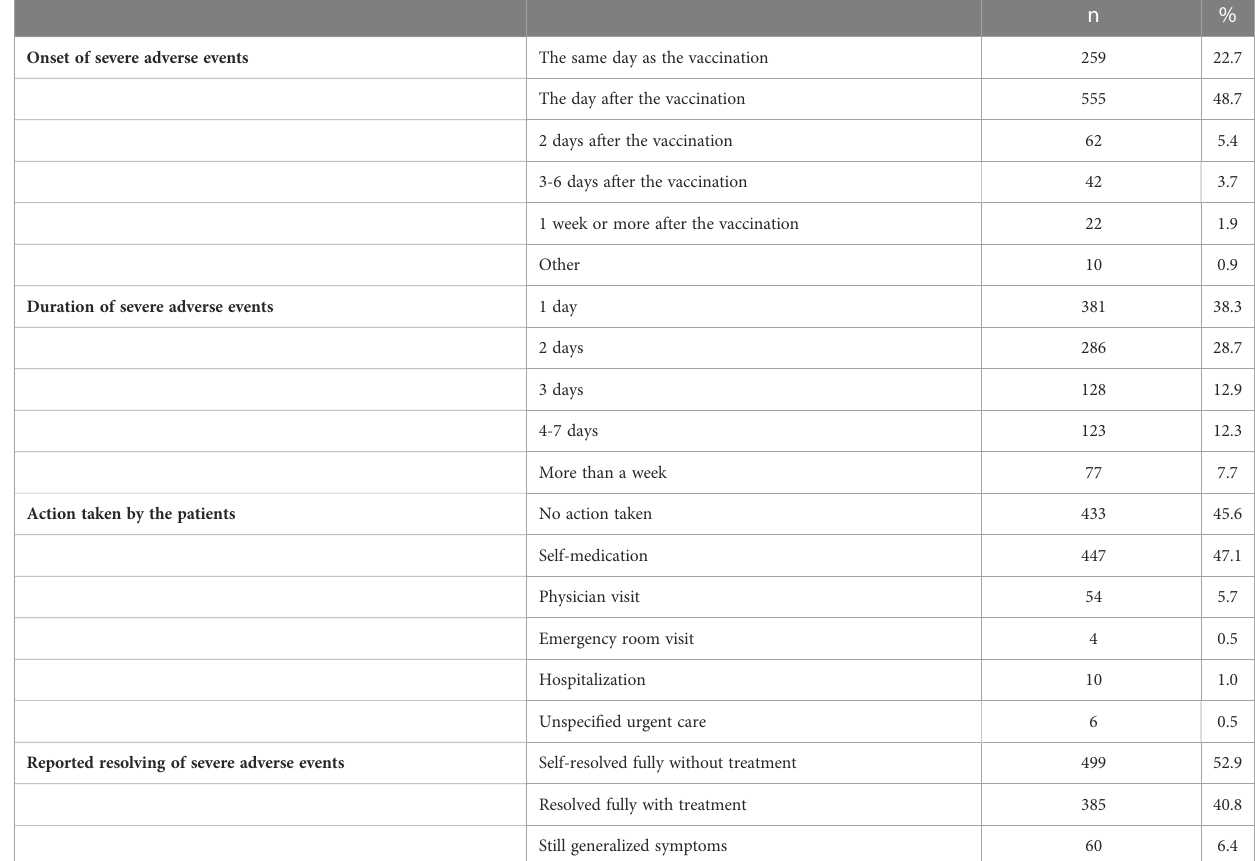
TABLE 4 Reported onset and duration of severe local or systemic AEs, actions taken and resolving of